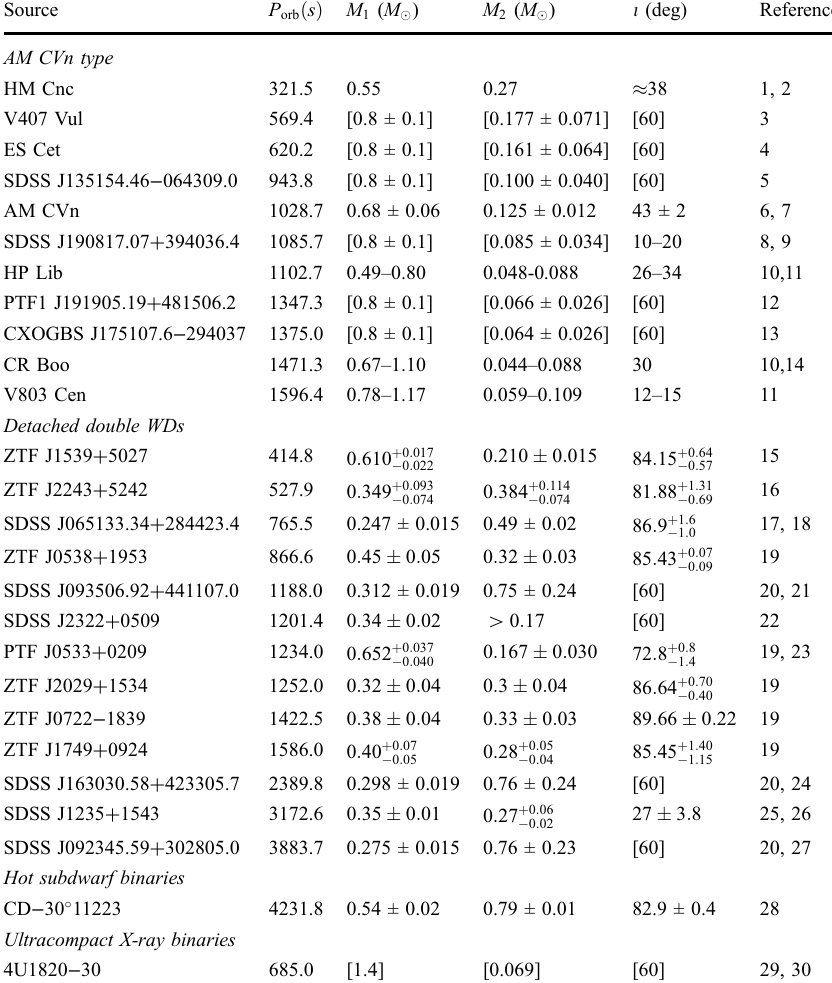
Table 1 Physical properties (orbital periods, component masses, inclination angles) of the known veri- fi cation binaries which reach a SNR [ 5 after a 10 year LISA mission with 80% duty cycle